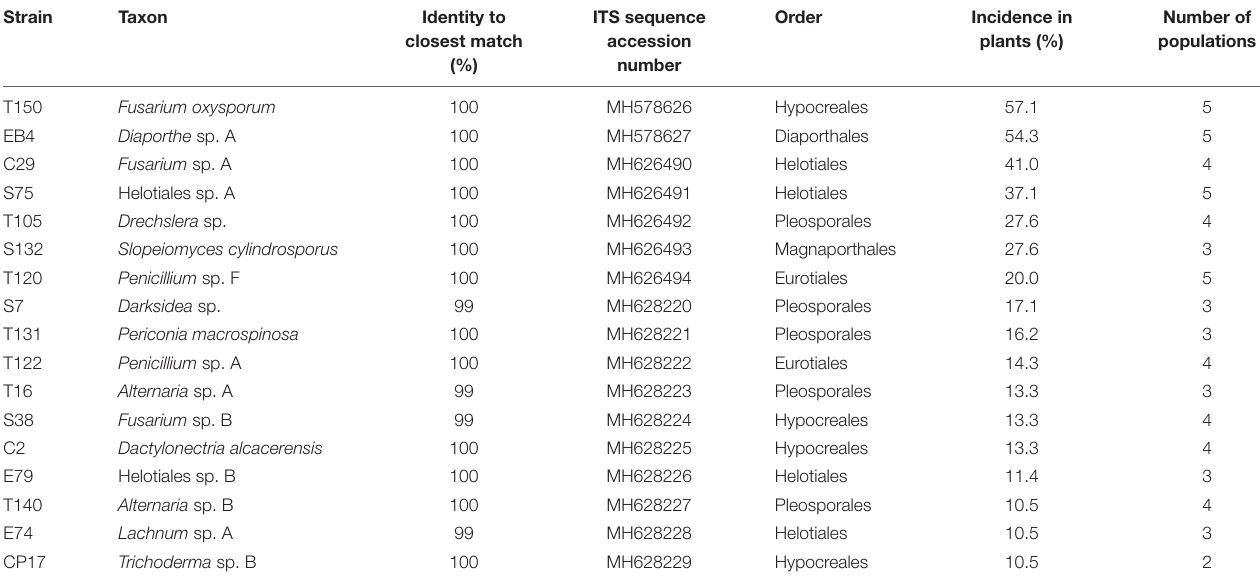
TABLE 2 | Core and abundant fungal species isolated from surface sterilized roots of Festuca rubra subsp. pruinosa at five populations from marine cliffs in northern Spain.